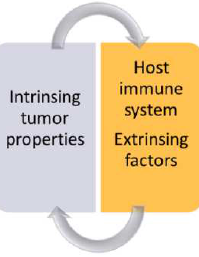
Figure 3. Immune response in cancer depends on tumor characteristics such as molecular alterations and the status of host immunity modified by environmental factors, such as, among others, sex hormones.